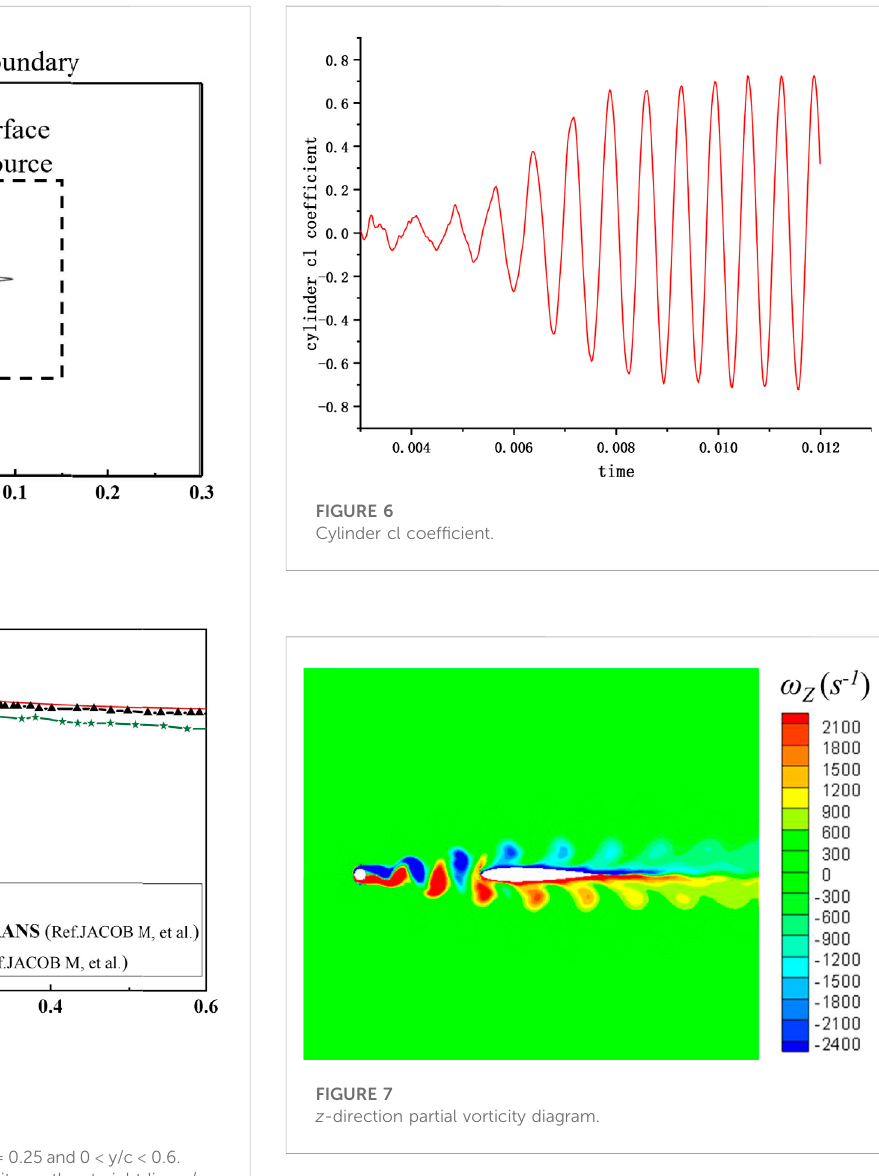
FIGURE 5 (A) Sub fi gure 1 is the locations of the x/c = 0.25 and 0 < y/c < 0.6. (B) Sub fi gure 2 is the average fl ow velocity on the straight line x/ c = 0.25.